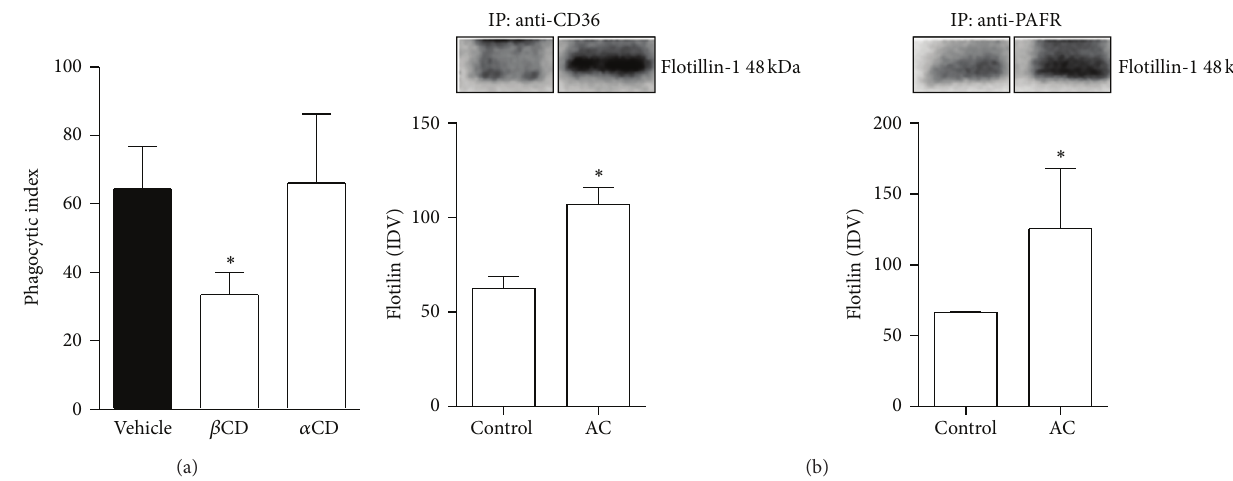
Figure 3: Efferocytosis requires lipid raft integrity. BMDM were treated with 𝛽 CD (1mM) or 𝛼 CD (1mM) for 10min before addition of apoptotic thymocytes (10 per macrophages) for 90 min for phagocytosis. After washing for removal of noningested targets, coverslips were stained with haematoxylin/eosin and the phagocytic indexes (derived by multiplying the percentage of macrophages containing at least one ingested target by the number of targets ingested by the macrophages) were assessed by cell counting under an optical microscope. Values are mean ± SEM of at least three independent experiments ( ∗ 𝑃 < 0.05 versus control) (a). In parallel, BMDM were incubated with apoptotic thymocytes (10 per macrophage) for 20 min before addition of lysis buffer. Cells lysates were subjected to immunoprecipitation/immunoblotting assays as described in Section 2 using antibodies to PAFR or CD36 and flotillin-1. Protein expression was quantified by the AlphaEaseFC software V3.2 beta. The autoradiographs show one representative experiment, and graph data are presented as mean ± SEM of three experiments ( ∗ 𝑃 < 0.05 )